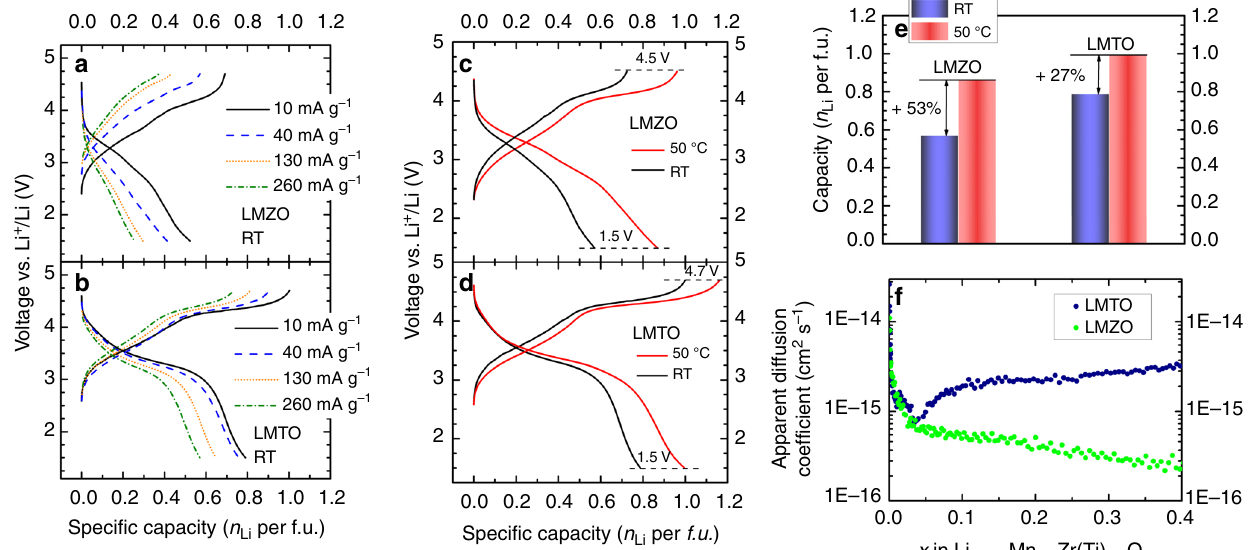
Fig. 2 Rate capability tests, comparison between high-temperature and room-temperature galvanostatic cycling of LMTO and LMZO, and PITT measurements. First-cycle voltage pro fi les of LMZO ( a ) and LMTO ( b ) when cycled between 1.5 and 4.7 V at 10, 40, 130, and 260 mA g − 1 . First-cycle galvanostatic voltage pro fi les of c LMZO and d LMTO at 50 °C and room temperature at 10 mA g − 1 . e First-cycle reversible capacities of LMZO and LMTO at high temperature and room temperature. f Li chemical diffusion coef fi cients of LMZO (green) and LMTO (blue) obtained from fi tting the room- temperature PITT data at various Li